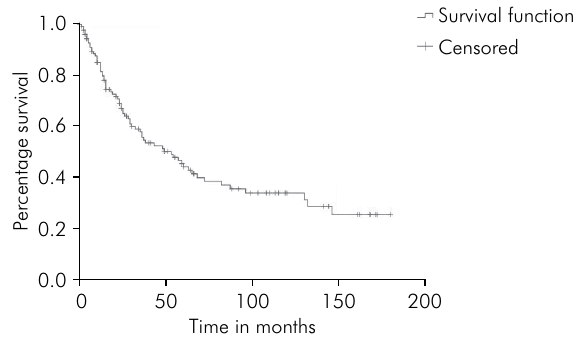
Figure. Survival function of recurrence of cavitated dentin carious lesion and/or restorations among patients with developmental disabilities, age ≥ 5 years in Belo Horizonte, Brazil, 1998 to 2019.